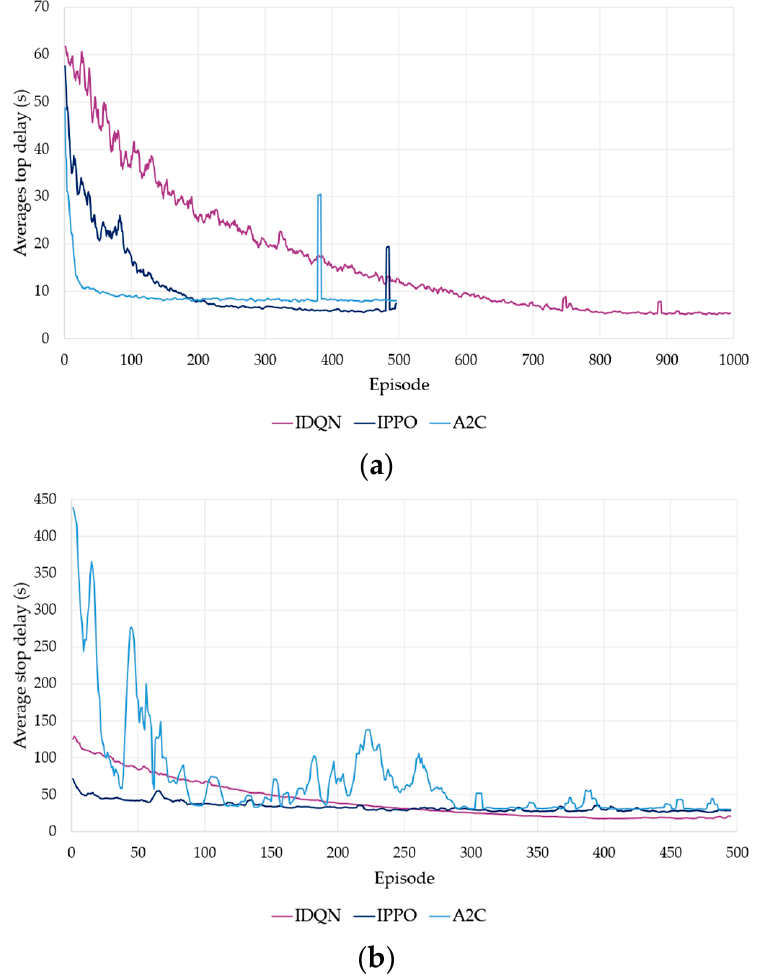
Figure 4. Learning curves of the RL algorithms: ( a ) “Cologne-8” scenario; ( b ) “Cologne-316”